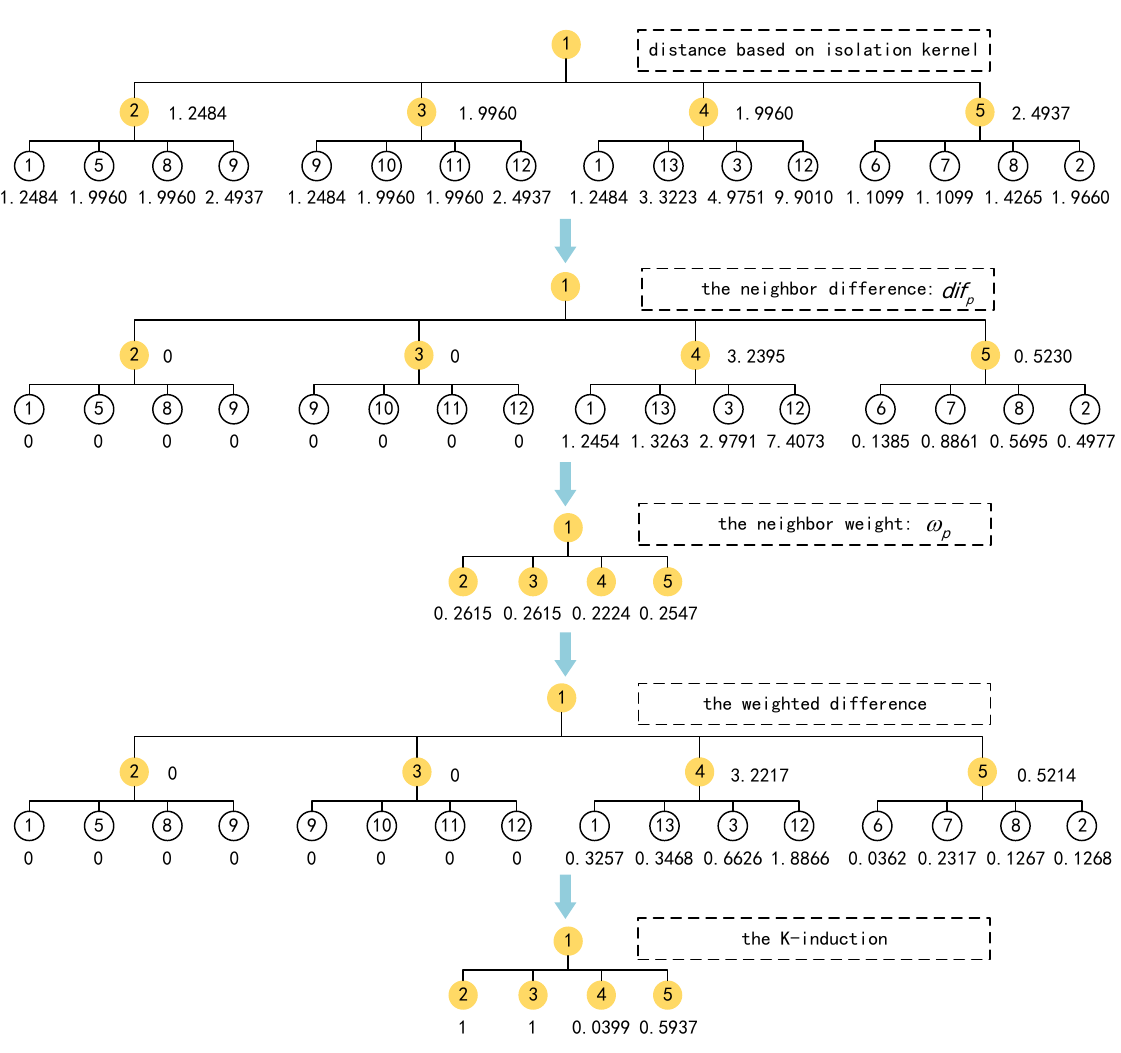
Figure 2. The detailed steps of K-induction